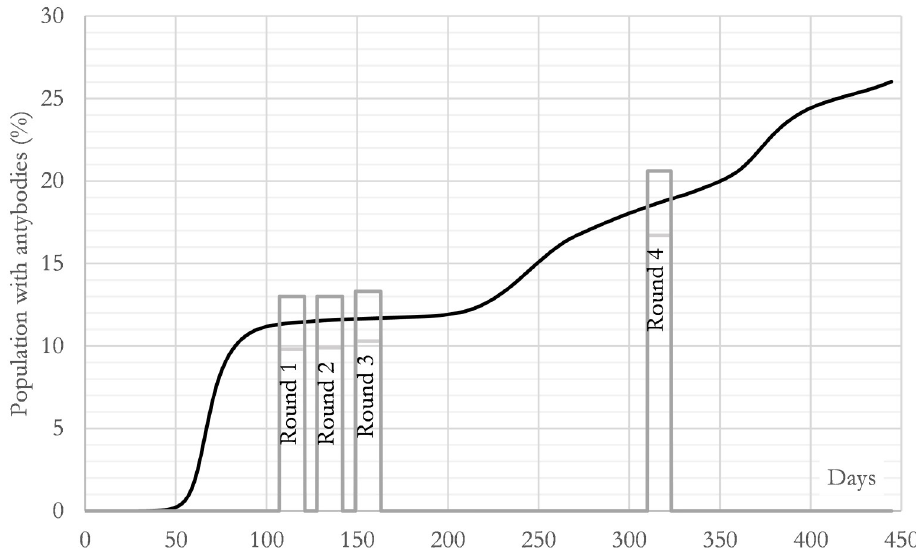
Fig 8. Calculated evolution of the infected individuals as a percentage of the total population in the region of Madrid (CM). Bars are the 95% confidence intervals in each round conducted by the ENE-COVID research [49, 50], which gives a measure of the persons with IgG antibodies against SARS-CoV-2. The solid line is the calculation made with the proposed